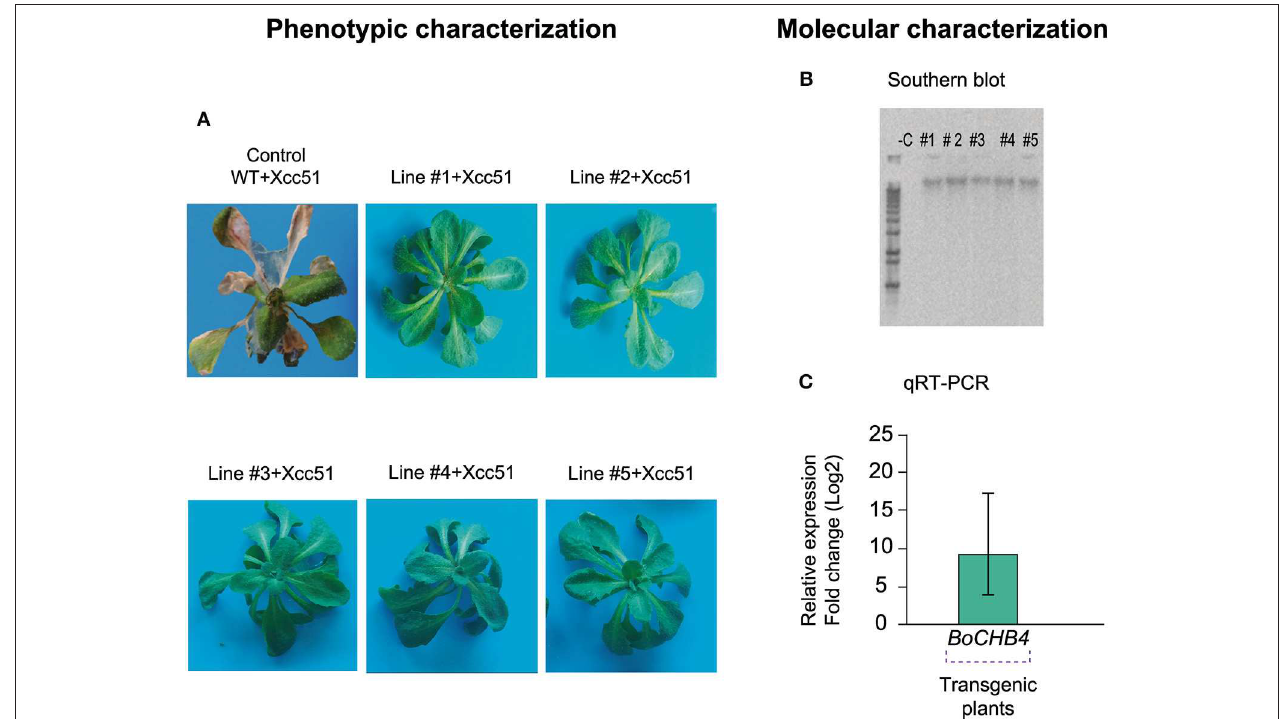
FIGURE 4 | Phenotypic and molecular evaluation of transgenic lines and wild type (WT) Arabidopsis thaliana plants. (A) A. thaliana plants (WT and #1–5 BoCHB4 lines) inoculated with Xanthomonas campestris pv. campestris (Xcc 51) at 5 days after inoculation (dai). (B) Southern blot analysis of A. thaliana transgenic lines (# 1–5) with BoCHB4 radiolabeled probe. (C) Relative expression of BoCHB4 gene in A. thaliana WT and transgenic lines (#